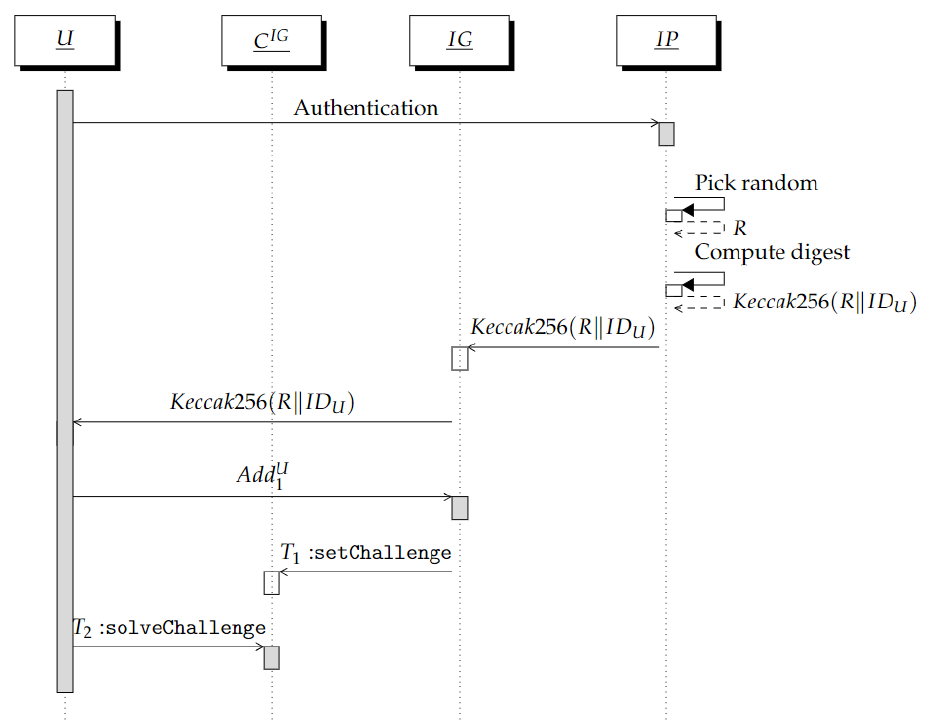
Figure 1. Sequence diagram of the interaction between U and IG